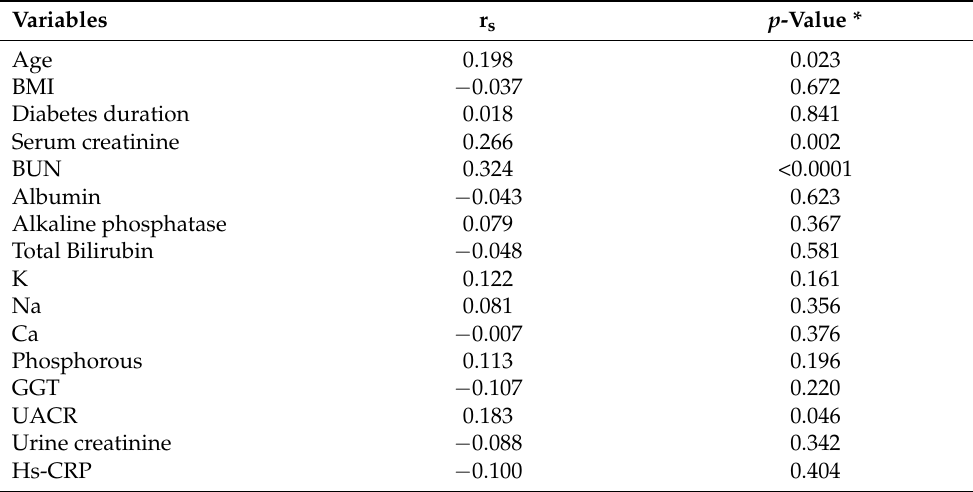
Table 3. Spearman’s rank correlation coefficient to assess the relationships between TMAO and markers of kidney function.